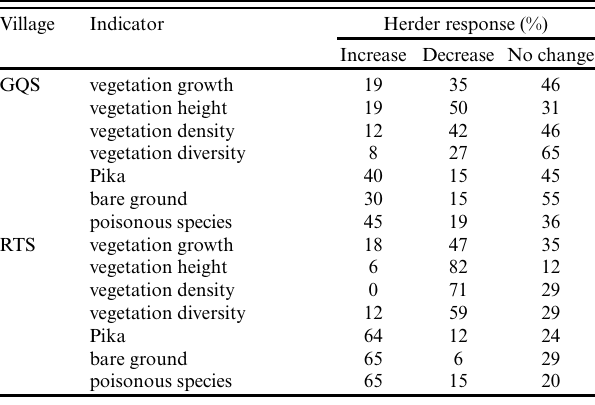
Table 5 . Herder perceptions of rangeland ecological conditions under the community-based grazing quota system (GQS, n = 30 households) and the rangeland transfer system (RTS, n = 20 households) in